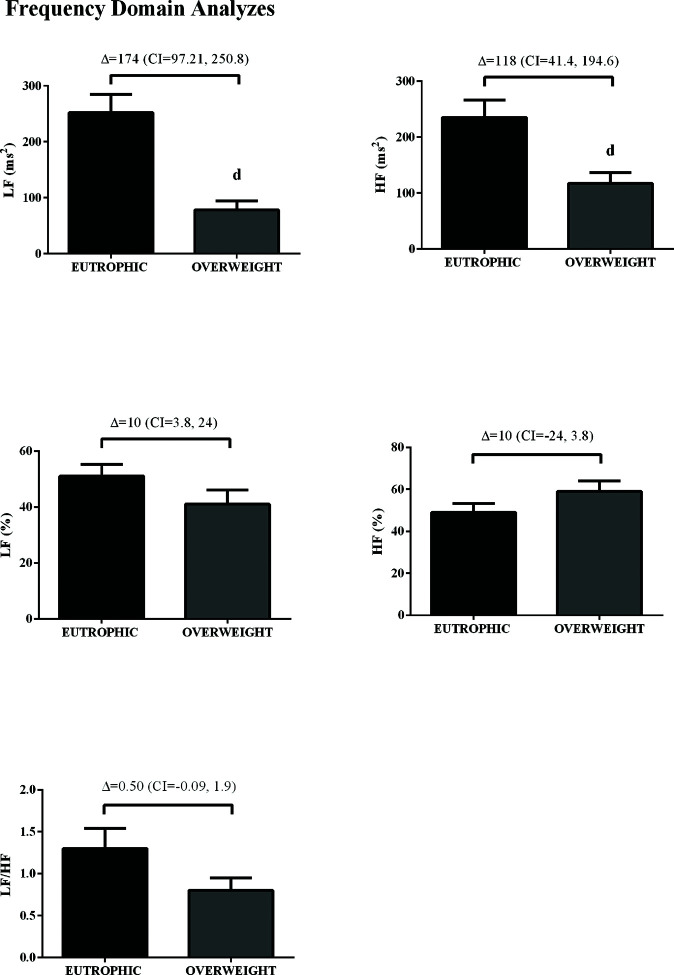
Values are presented as mean±standard deviation or adjusted mean difference (95% confidence interval). dp<0.05 vs. euthrophic.